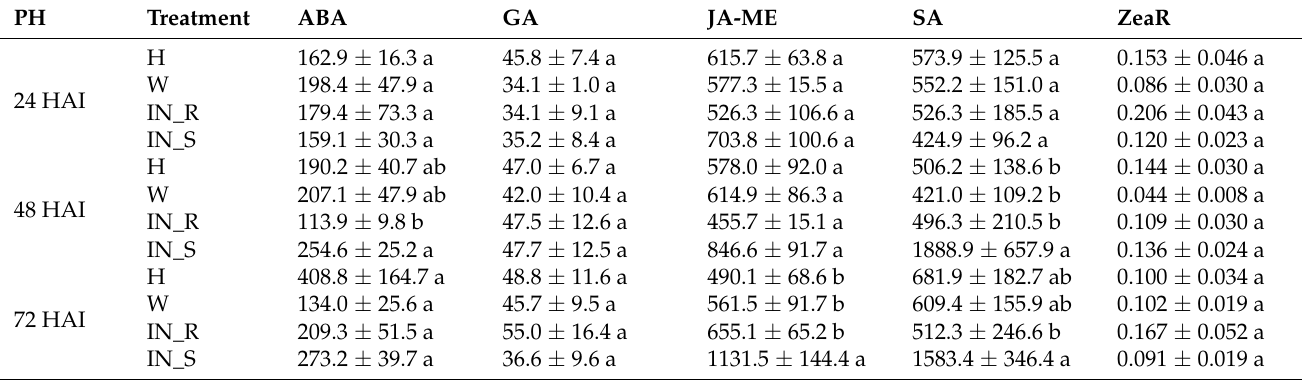
Table A1. Phytohormones (PH) quantification in stem tissues of 2-year-old Pinus pinaster half-sib plants (ng/g), 24, 48 and 72 h after inoculation (HAI) with the pinewood nematode (PWN) Bursaphelenchus xylophilus . Plant treatments include healthy non-inoculated (H), mock-inoculated/wounded (W), PWN-inoculated resistant (IN_R) and PWN-inoculated susceptible (IN_S). Data are presented as means ± SE of five independent biological replicates. Different letters indicate significant differences calculated using Tukey HSD test for multiple comparisons ( p <